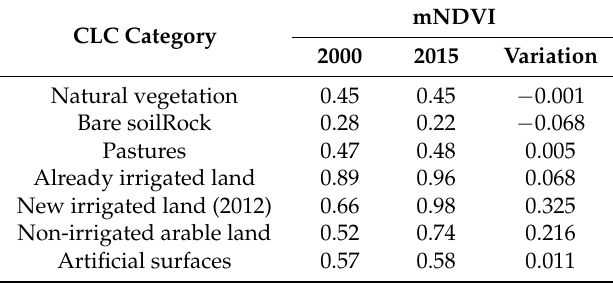
Table 9. Average mNDVI in 2000 and 2015 for the main CLC